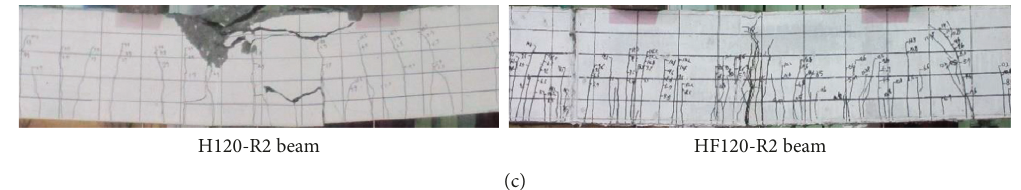
Figure 6: Crack and failure patterns of the HSC and HSFRC beams. (a) Initial cracking state. (b) Yielding state. (c) Ultimate